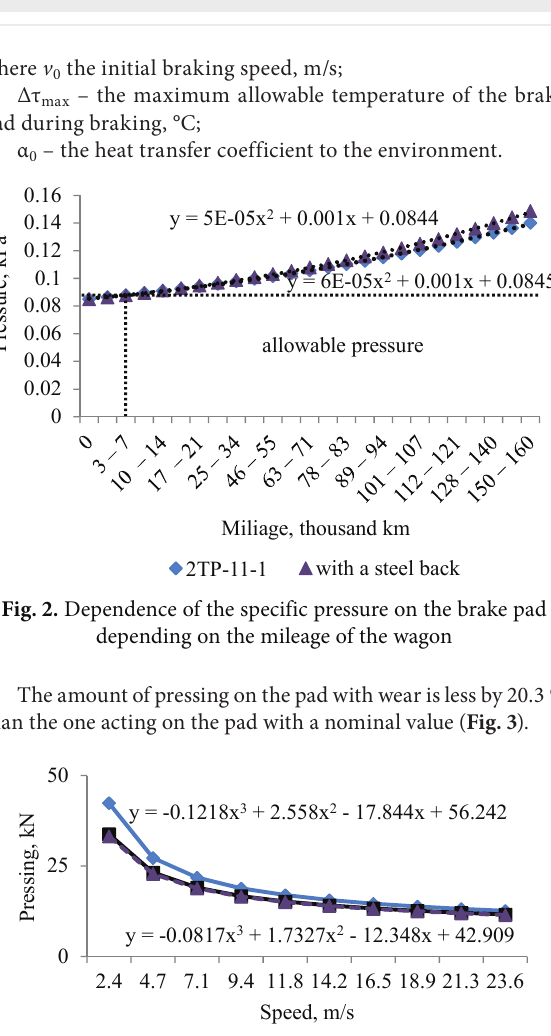
y = -0.0817x 3 + 1.7327x 2 - 12.348x +